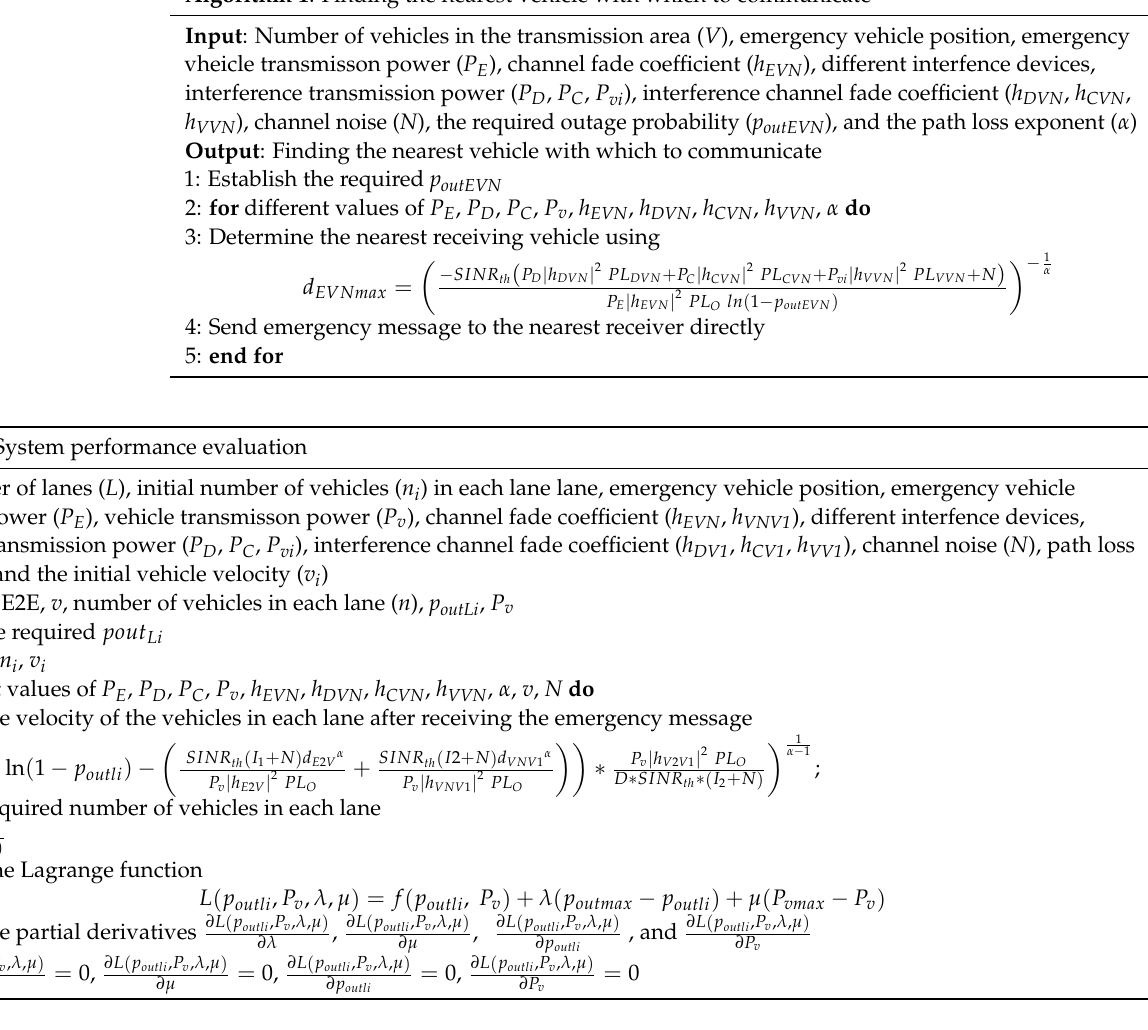
Algorithm 1 : Finding the nearest vehicle with which to communicate